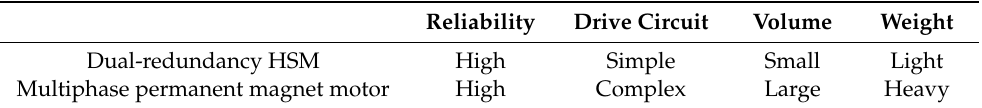
Table 6. Contrast with multiphase permanent magnet